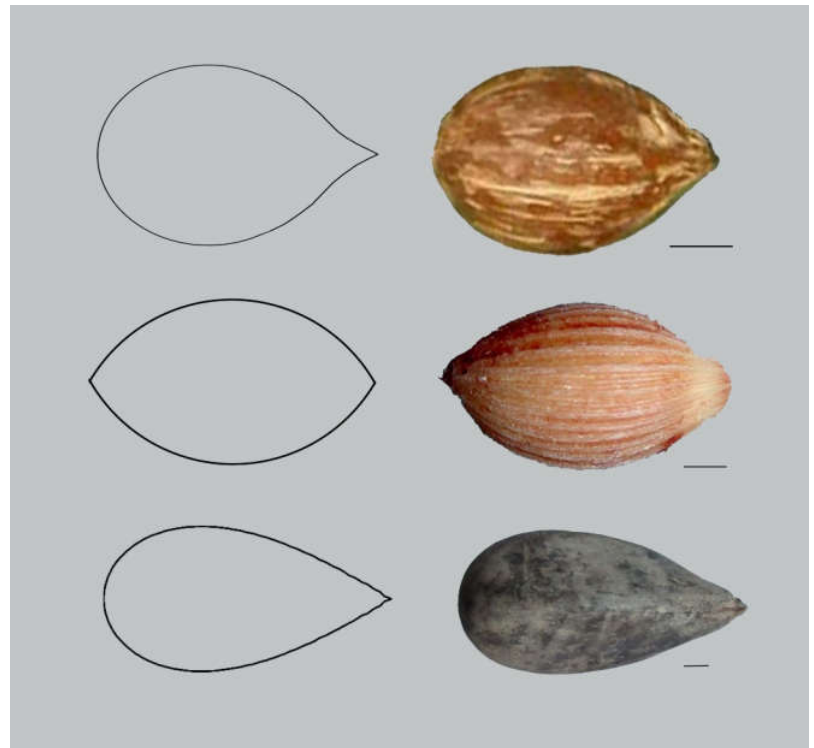
Figure 9. Water Drop, Lens, and Half Lemniscate with examples of seeds resembling each of the models (between parenthesis values of J index with the respective model): Syagrus romanzoffiana (92.3, mean of three seeds), Asterogyne martiana (91.8), and Aphandra natalia (93.8). Bars represent 0.5 cm. Horticulturae 2020 , 6 , 64 6. Seed Shape Quantification by Comparison with an Oval in Chamaedorea pauciflora